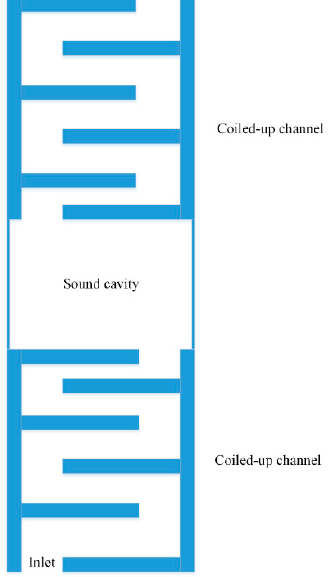
Figure 20. Configuration of the proposed sound energy-harvesting system.